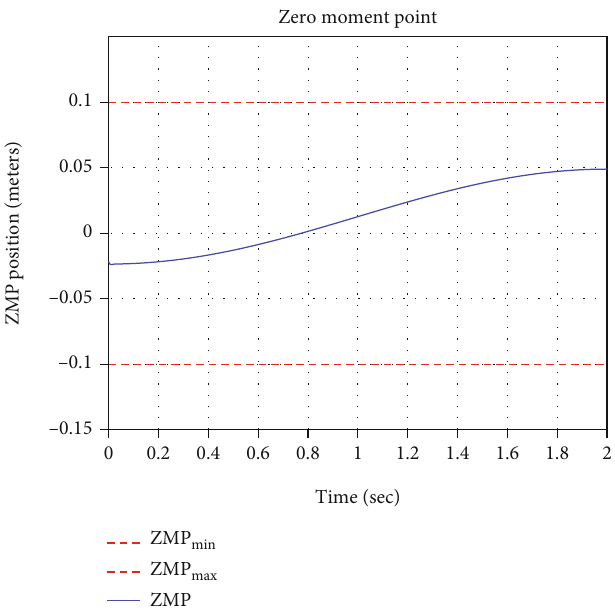
Figure 5: Position of the ZMP for the CTC control. The boundaries of the robot ’ s support polygon are ½ − 0 : 1, 0 : 1 (cid:2) represented by the dashed horizontal lines.